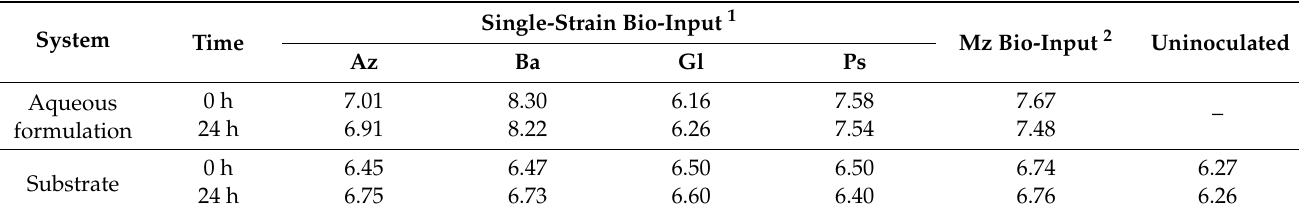
Figure 2. Bacterial populations of each strain in aqueous formulation and in inoculated substrate at time “0” and after 24 h of storage post-formulation or post-inoculation, respectively. In the figure, average of log CFU per ml of bio-input and average of log CFU per g of substrate (and standard deviation of data) of each strain are plotted. Az: A. argentinense Az39; Ba: Bacillus sp. Dm-B10; Gl: G. diazotrophicus PAL5; Ps: P. protegens Pf5. An asterisk above the bar indicates significant differences between means. Table 1. pH values of aqueous formulations and substrate at time “0” and after 24 h of storage post-formulation or post-inoculation, respectively.